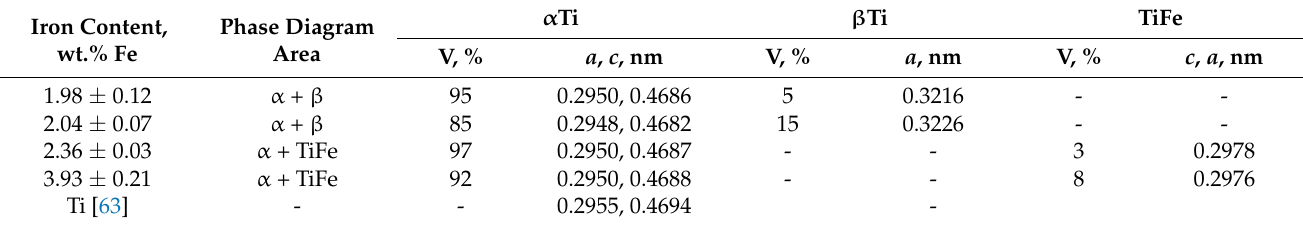
Table 1. Lattice parameters, phases and their volume fraction in alloys after heat treatment. Iron Content, Phase Diagram wt.% Fe